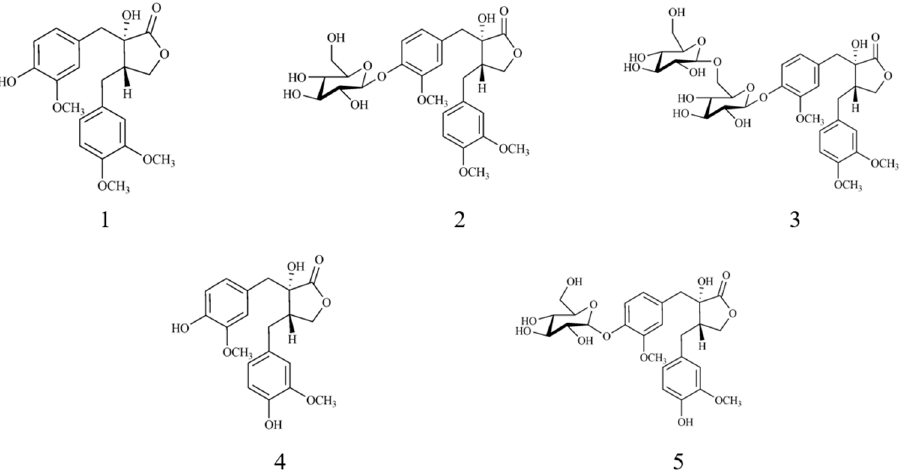
Figure 1. Chemical structures of compounds 1 – 5 .